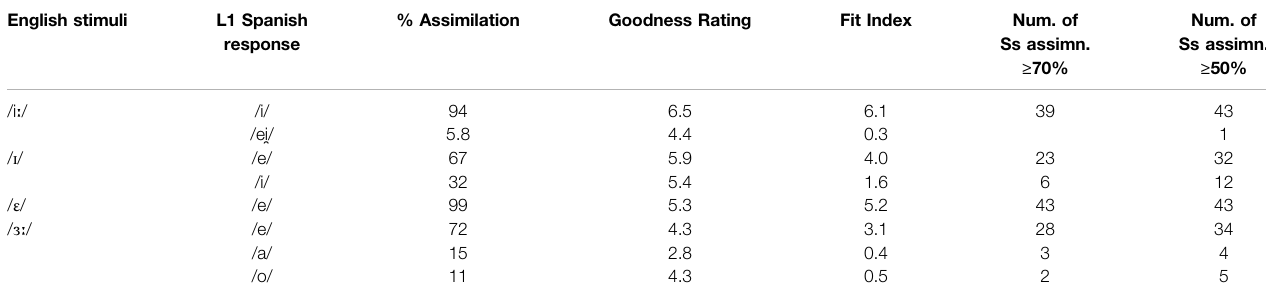
TABLE 2 | Perceived similarity between nonnative (English) vowels and L1 (Spanish) vowels. (Num. of Ss assim. ≥ 70%/50% (cid:2) number of subjects who selected a given response 70%/50% of the time or more). The total number of participants was 43. English